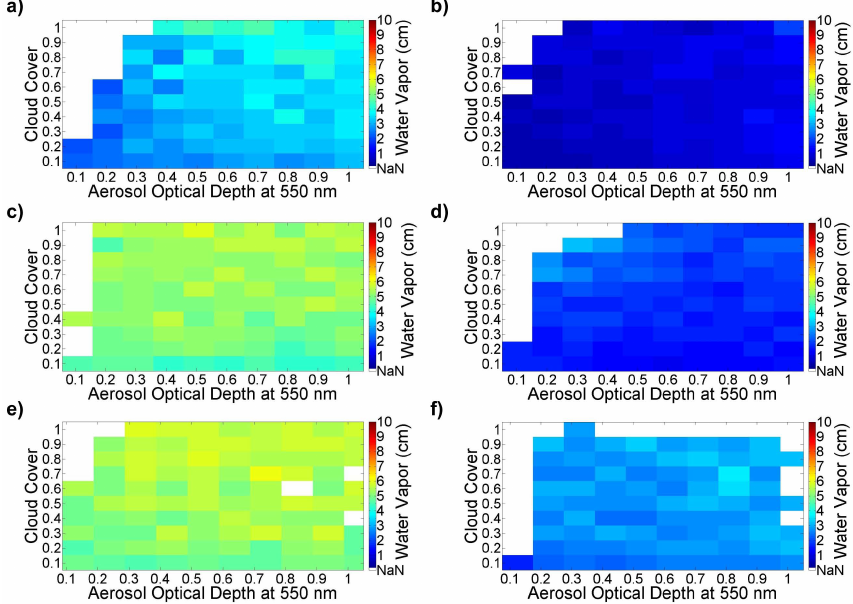
Figure 5. MODIS AQUA mean WV amounts for 0.1 AOD and 0.1 CC bins over the (BTH) (top), YRD (middle), and PRD (bottom) urban clusters for 2003–2013, for SLP<1008hPa (left) and SLP>1017hPa (right). NaN on the cloud data color bar denotes no values or fewer than six values in this bin.